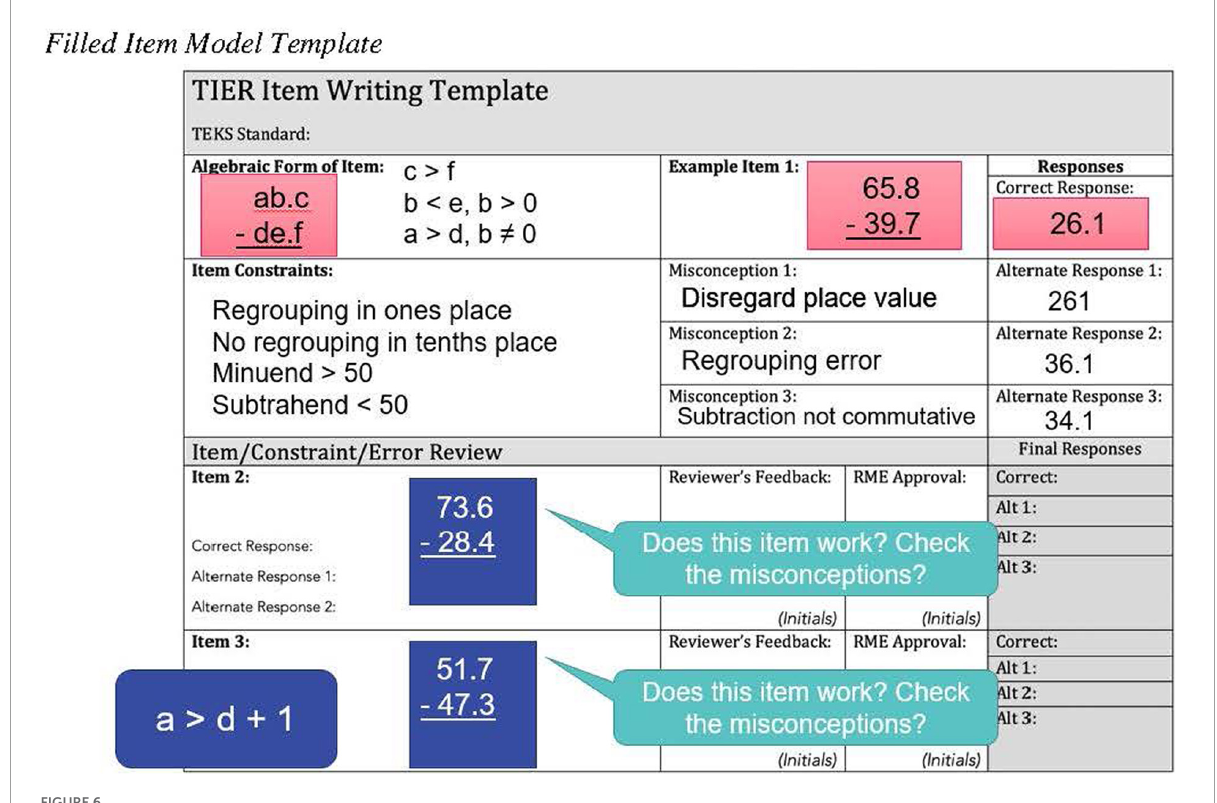
FIGURE6 Filled item model